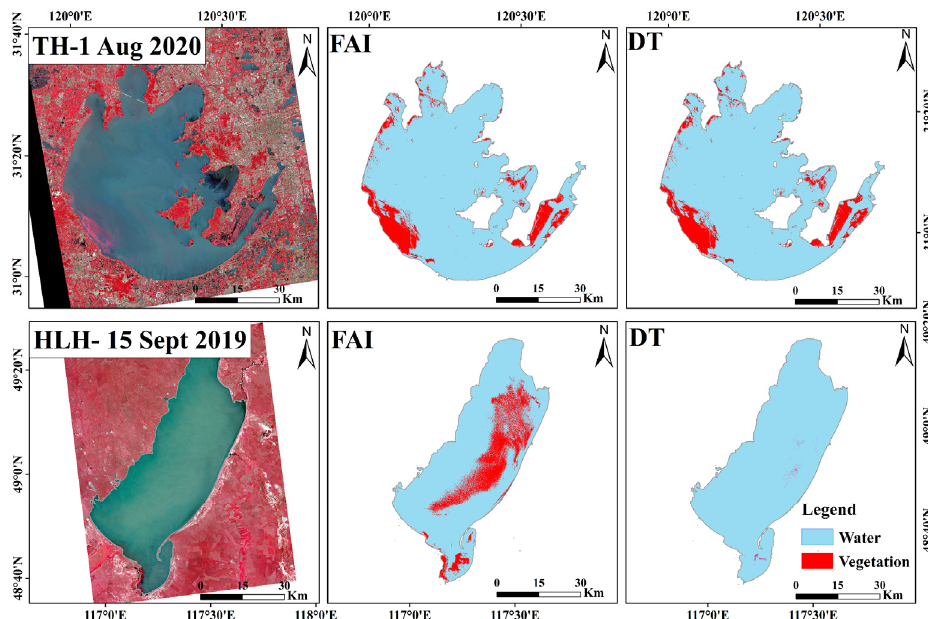
Figure 7. Results of vegetation signal extraction with FAI and decision trees (DT) in standard false ‐ color (NIR, red, and green) images of Lake Taihu and Lake Hulun. “TH-1 Aug 2020” represents an color (NIR, red, and green) images of Lake Taihu and Lake Hulun. “TH ‐ 1 Aug 2020” represents an image of Lake Taihu on 1 August 2020. “HLH ‐ 15 Sept 2019” represents an image of Lake Hulun on image of Lake Taihu on 1 August 2020. “HLH-15 Sept 2019” represents an image of Lake Hulun